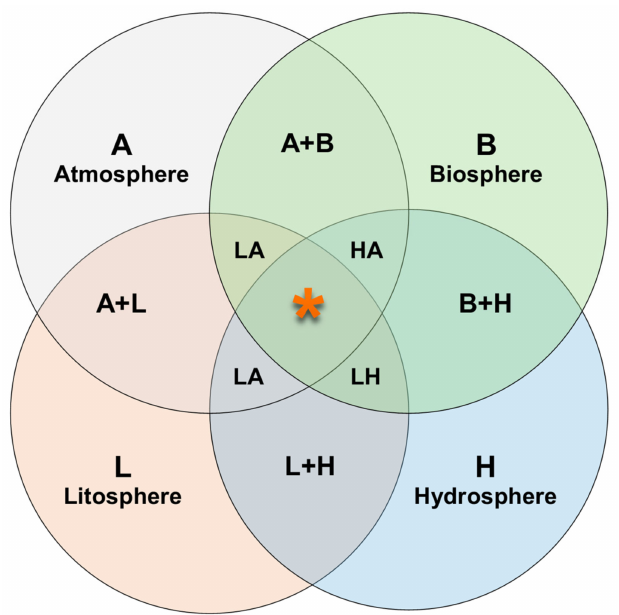
Figure 1. Conceptual scheme of the relationships between the main spheres considered by the Earth systems science [1]. Asterisk indicates the area of relationships with pedosphere and anthroposphere. According to Gray’s (2013) definition, geodiversity is not just a matter of di ff erent Earth features